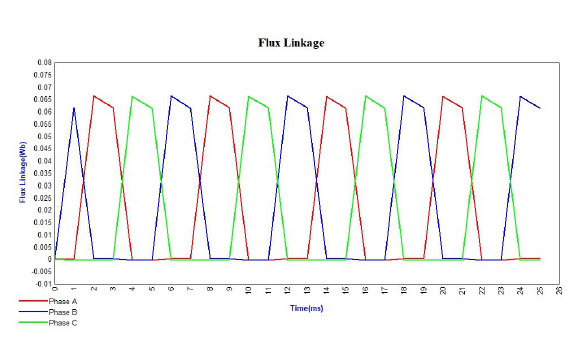
Fig. 8. 8/6 SRM flux linkage.